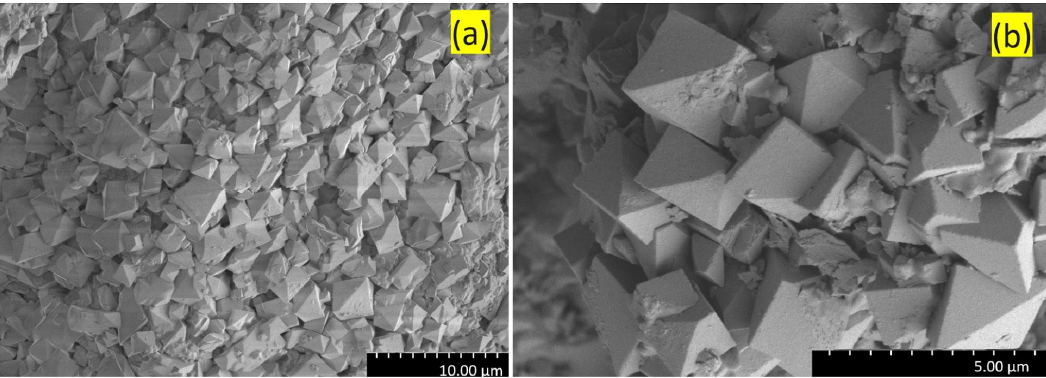
Figure 12. SEM images (SE) of the trigonal antiprismatic crystals of jarosite at different magnifications acquired from a Stefføya sample: ( a ) at lower and ( b ) higher magnifications